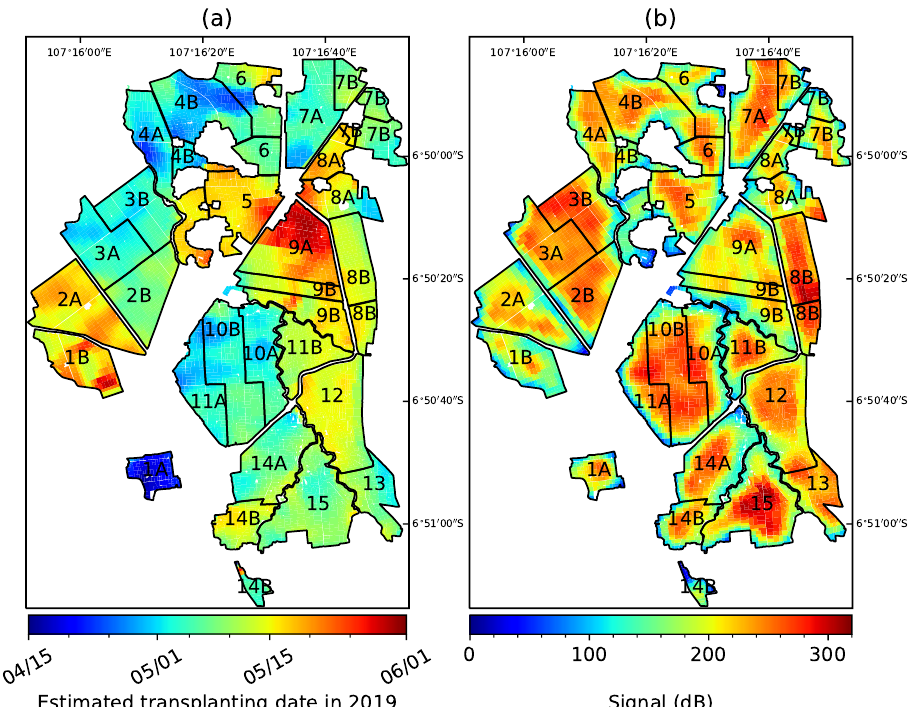
Figure 5. Maps of estimated transplanting date ( a ) and field average signal intensity ( b ) (first crop in the dry season of 2019).